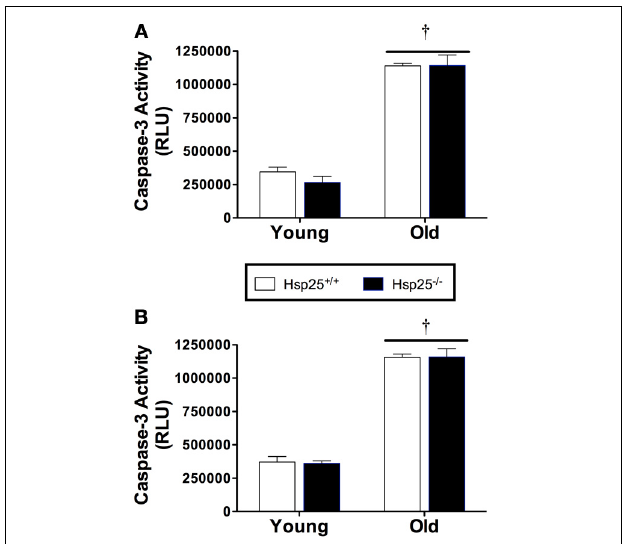
FIGURE 6 | Average caspase-3 activity (RLU, relative light units) in young and old Hsp 25 + / + and Hsp 25 − / − mice following muscle contractile measurements (A) or 2 weeks of running wheel activity (B). † Significant main effect of age ( P < 0 . 0001). Data are presented as means ± SE, n = 8 for muscle force groups and n = 10 for running wheel